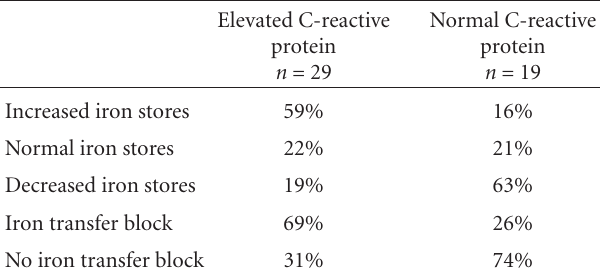
Table 5: Iron stores and prevalence of iron transfer block for patients with elevated C-reactive protein and patients with normal C-reactive